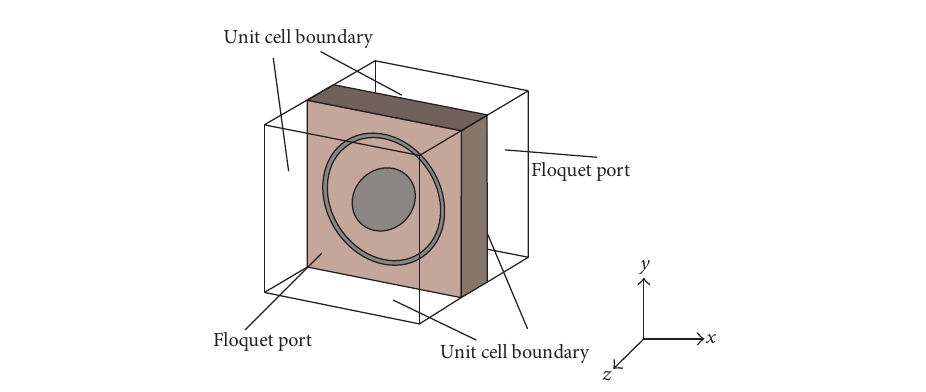
Figure 1: Schematic of the simulation.